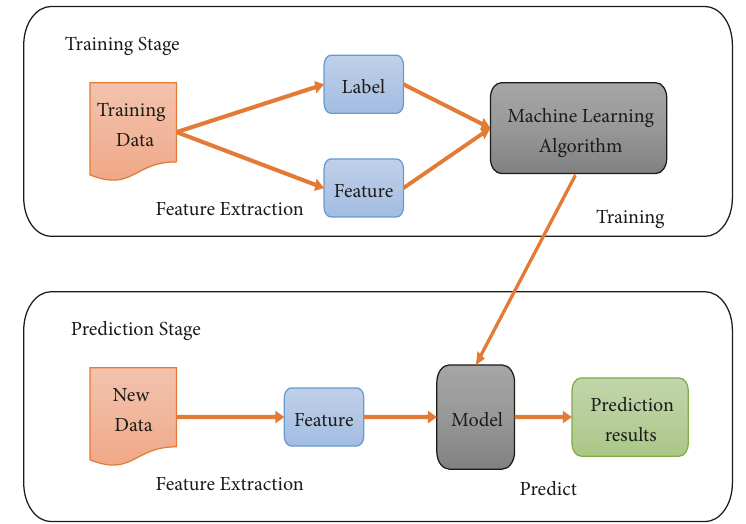
Figure 4: A basic machine learning